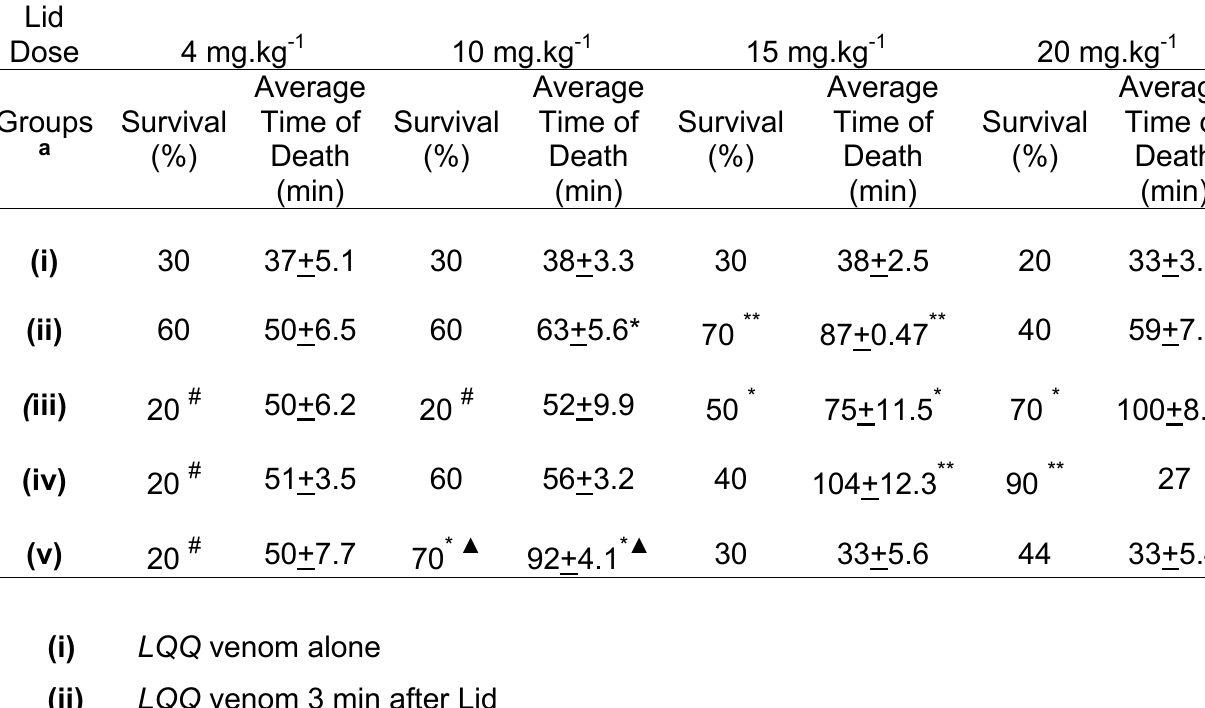
Table 3: Percent survival and average time of death of mice intravenously injected with lidocaine (Lid) at different times before and after LQQ venom (250 µg.kg -1 ,